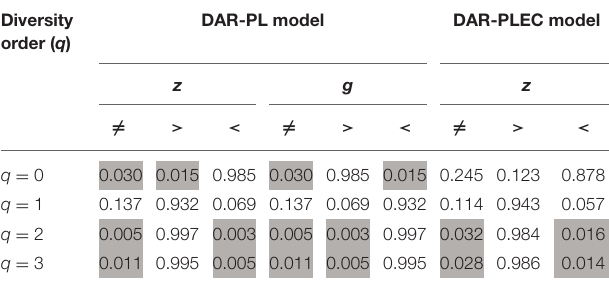
TABLE 3 | The p -values of Wilcox non-parametric significance test between the differences between Archaea and Bacteria in their DAR parameters. Diversity order ( q )